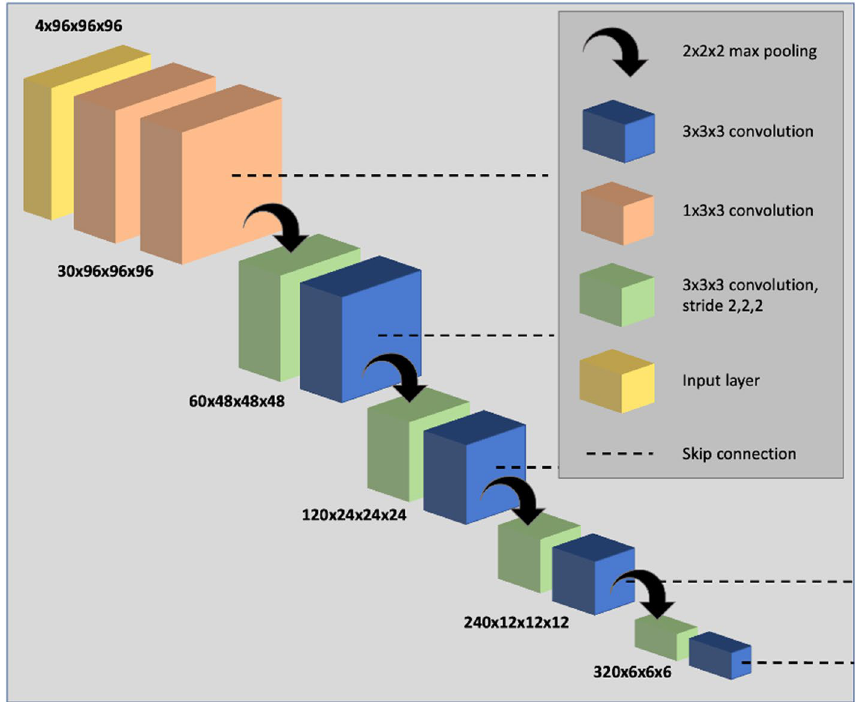
Figure 1. Visual representation of the modified 3D nn-UNet network used in this work. The deconvolution side of the network is omitted as it follows the same structure as the convolutional path, however, with the addition of a 1 × 1 × 1 SoftMax